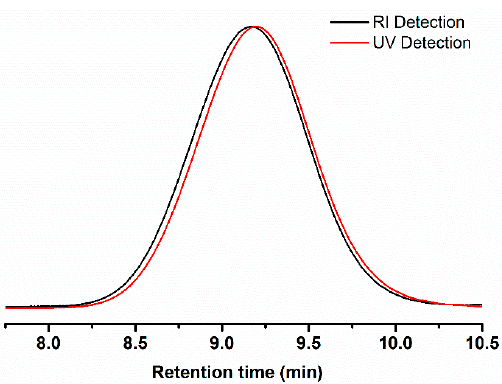
Figure 1. 1 H NMR (in CDCl 3 ) spectra of PS-Se-1.